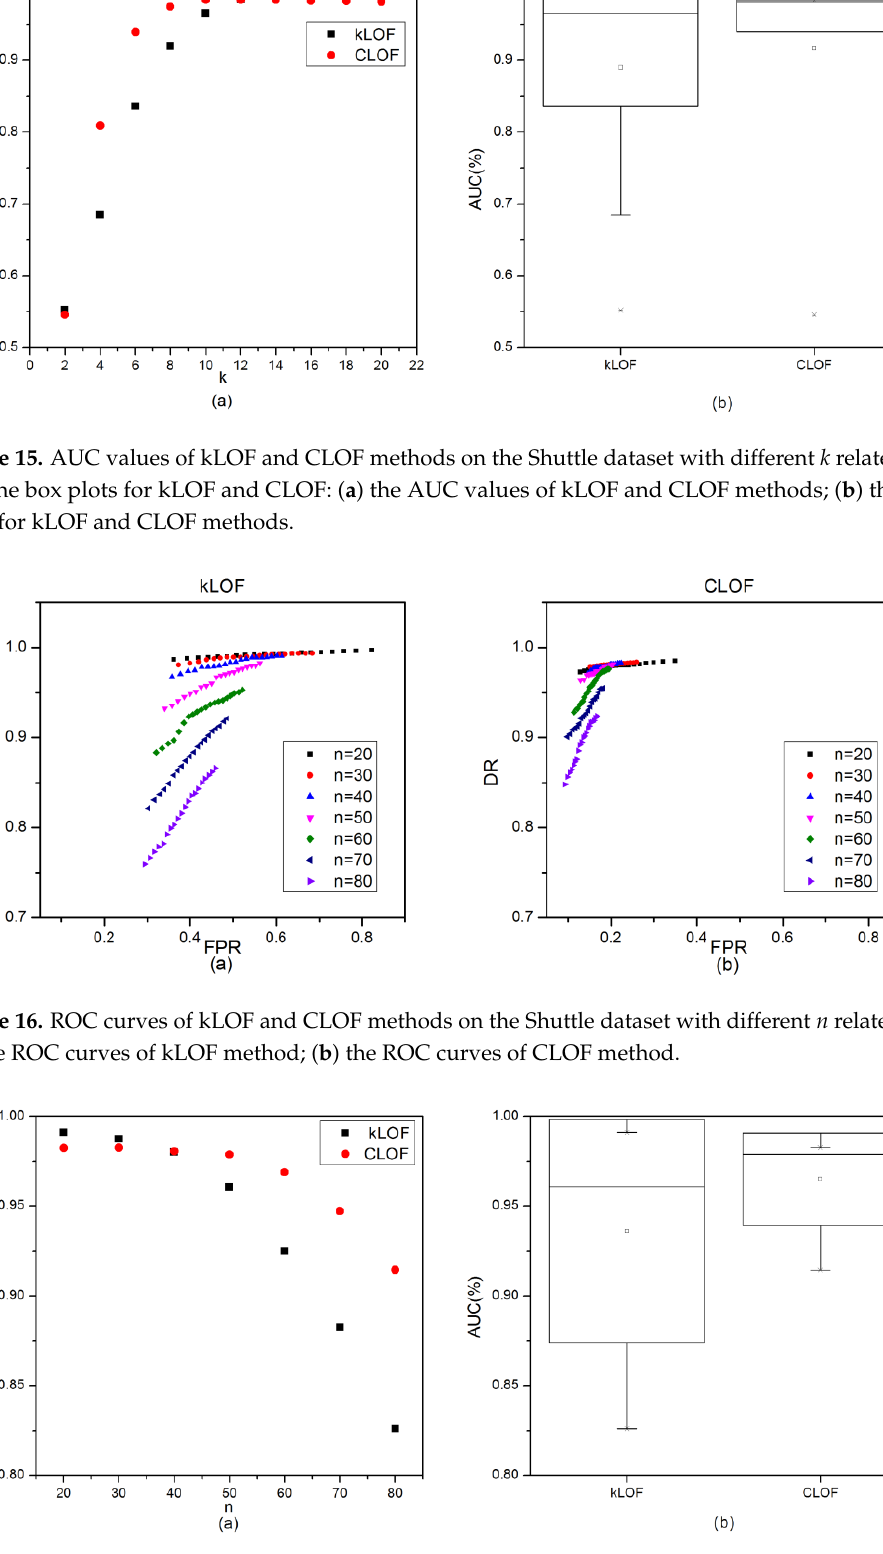
Figure 17. AUC values of kLOF and CLOF methods on the Shuttle dataset with different n related to and the box plots for kLOF and CLOF: ( a ) the AUC values of kLOF and CLOF methods; ( b ) the box plots for kLOF and CLOF methods.